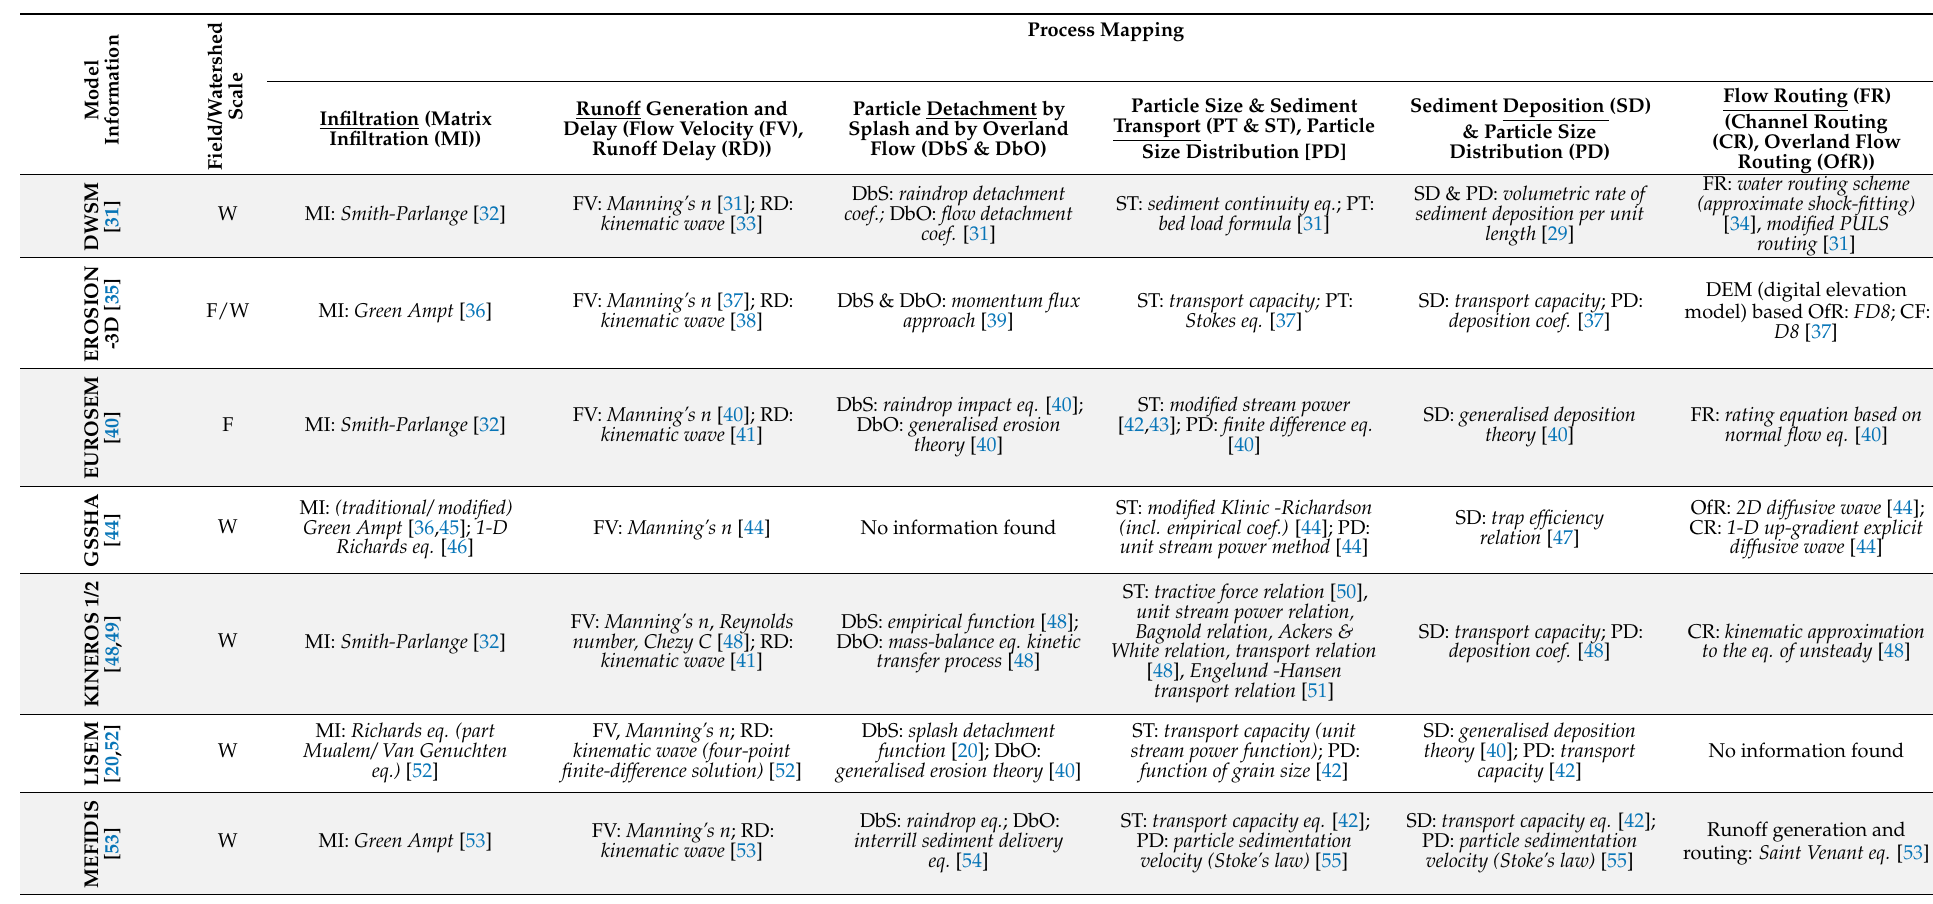
Table 1. Process-based (distributed and event-based) soil erosion models and their basic equations regarding their processes mapping (coefficient = coef., equation = eq.). The meaning of the models’ acronyms can be found in Appendix A. The table is derived from the process-based soil erosion models reviewed by Aksoy and Kavvas [22], Karydas et al. [24], Hajigholizadeh et al. [23], Merritt et al. [25] and Pandey et al. [21]. To ensure a good overview, only models with at least 10 publications since 2000 were included in the following